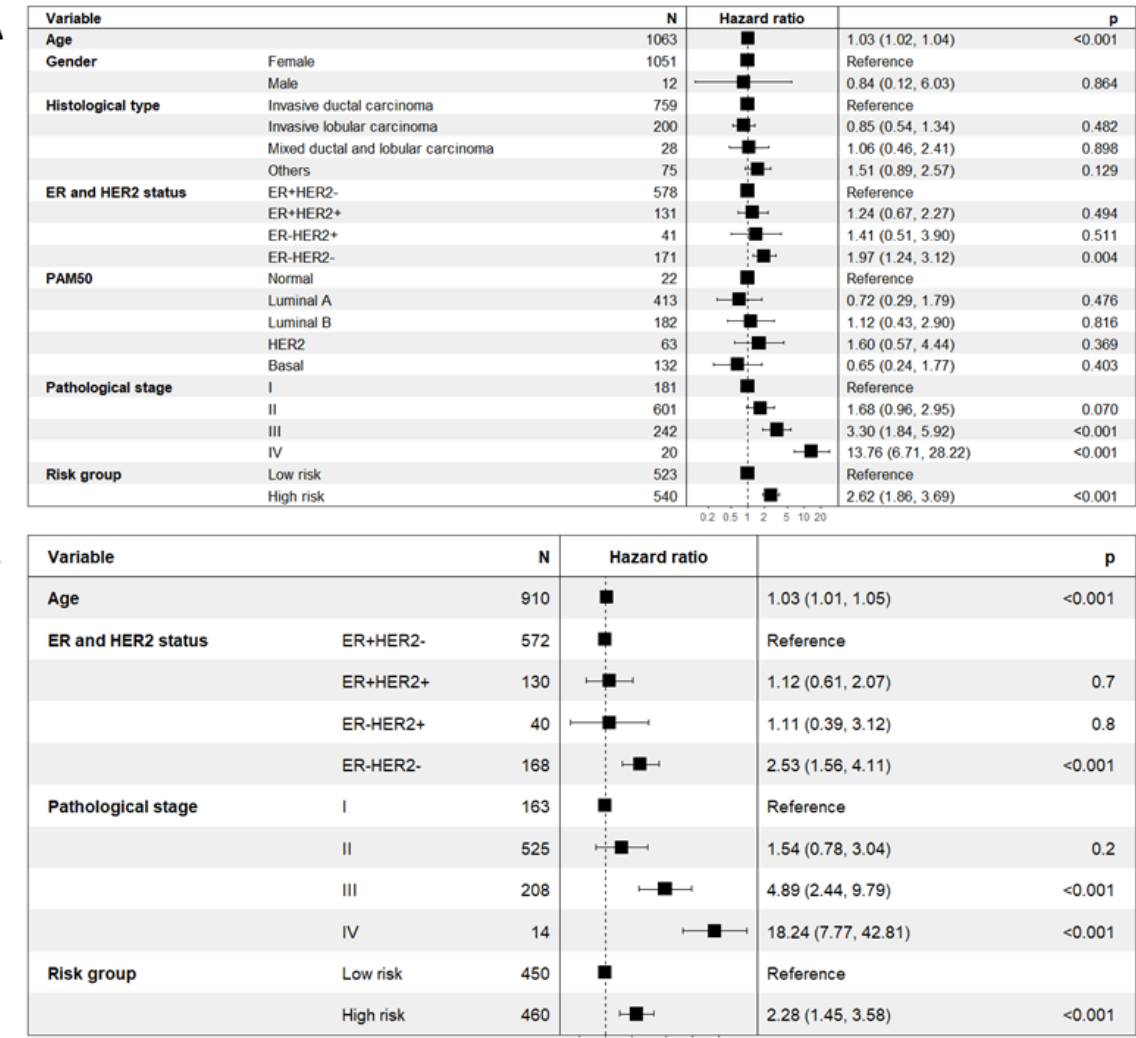
Figure 6. Univariate and multivariate Cox proportional hazards regression analysis for pertinent clinicopathological parameters. ( A ) Higher pathological stages (stage III and IV), ER and HER2 negative status, higher age and high-risk groups were significant poor prognostic factors in univariate analysis. ( B ) High-risk group remains an independent poor prognostic factor ( p value < 0.001) in the multivariate analysis.